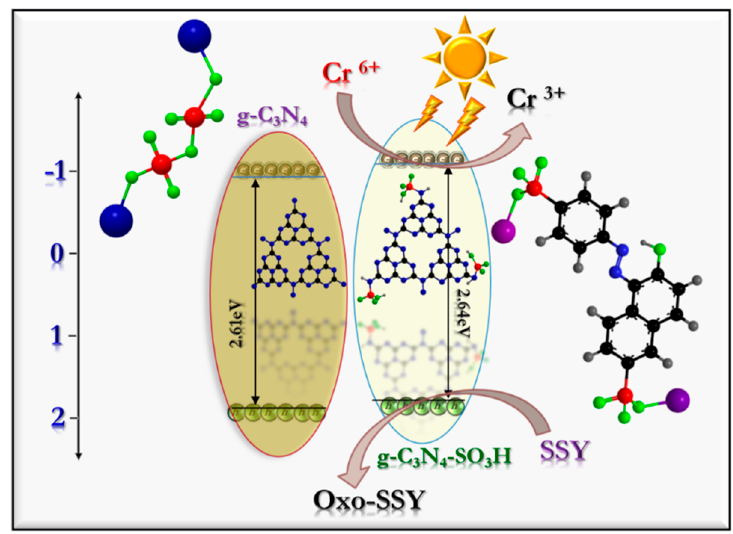
12 of 20 Figure 11. ln (C/C o ) vs. the degradation time fitted with pseudo-first-order kinetics for the photore- duction of Cr(VI) ( A ) and photooxidation of SSY FCF ( B ). Interpreting the results mentioned above, the plausible photocatalytic mechanism for the photo–redox reactions for the degradation of the Cr (VI) and SSY contaminants was formulated and is displayed in Scheme 1. The bandgap energies of the g-C 3 N 4 (2.61 eV) and g-C 3 N 4 –SO 3 H (2.64 eV) semiconductor photocatalysts were derived by Tauc plots ob- tained from the UV–diffuse reflectance spectra and the position of the conduction band (CB) established by the Mott–Schottky measurements. The valence band (VB) position was calculated using the formula mentioned below (Equation (7)). E (cid:2887)(cid:2886) (cid:3404) E (cid:2906)(cid:2886) (cid:3398) E (cid:2917) (7) where E VB = valence band energy, E CB = conduction band energy, and E g = bandgap energy. The valence band (VB) and conduction band (CB) energies of the g-C 3 N 4 and g-C 3 N 4 –SO 3 H photocatalytic materials were measured to be +1.66 eV/+1.55 eV and − 0.95 eV/ − 1.09 eV,